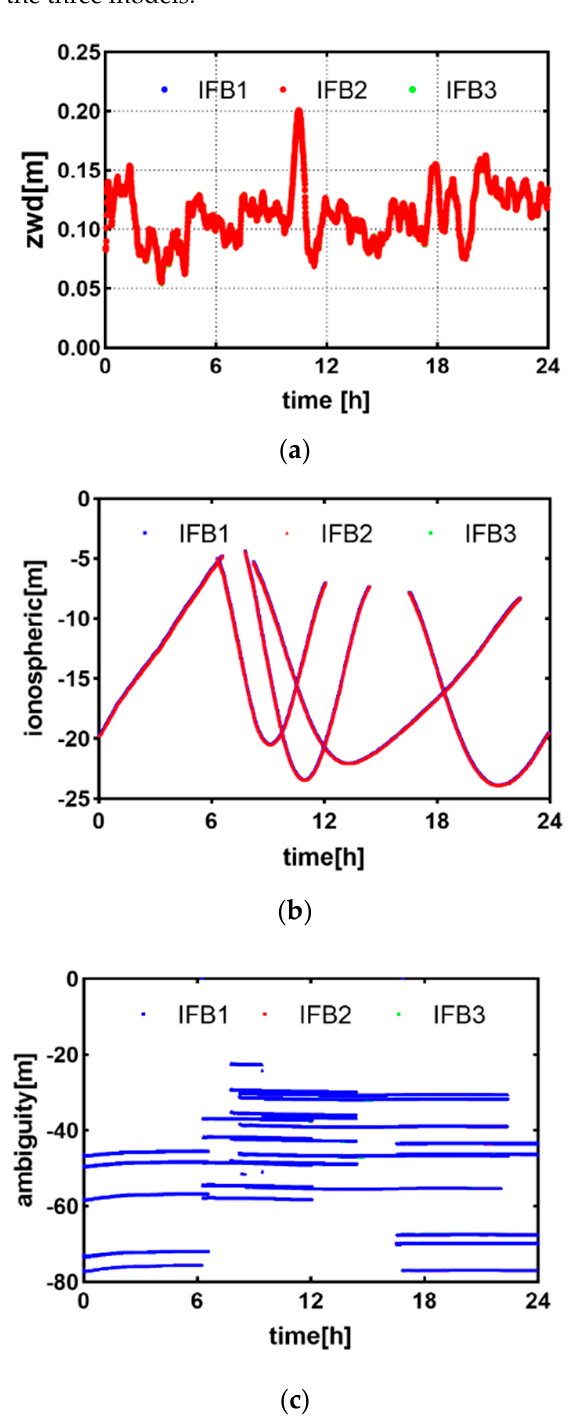
Figure 5. The tropospheric ZWDs, slant ionospheric delays, and ambiguities of BDS-3 UC-PPP among different IFB handling schemes for station KRGG on DOY 001, 2022. Subfigures ( a ) is the tropospheric ZWDs of for station KRGG. Subfigures ( b , c ) are the slant ionospheric delays and float ambiguities of MEO satellites C19 and C20 and IGSO satellites C39 and C40, respectively.